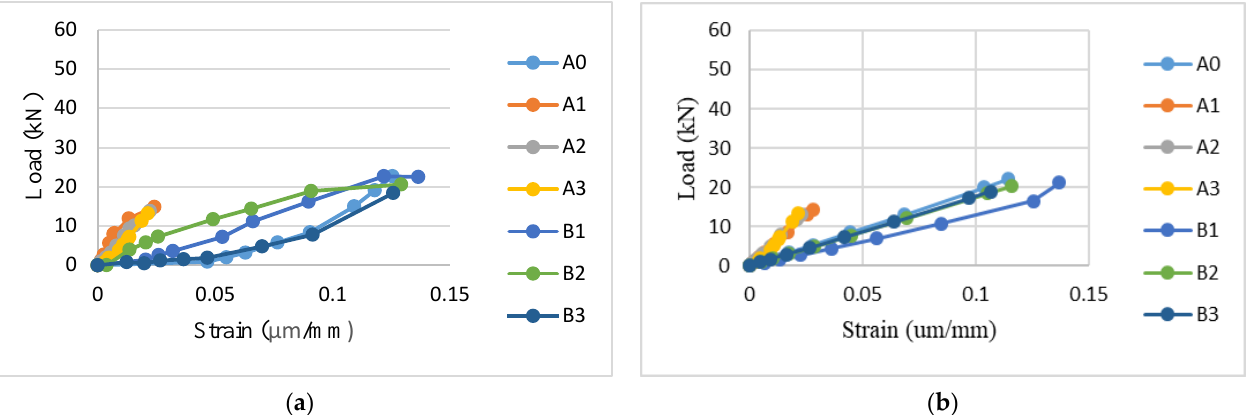
Figure 9. Strain comparison for failure load of circular and square potholes without patching. ( a ): experimental results. ( b ): numerical simulation results.